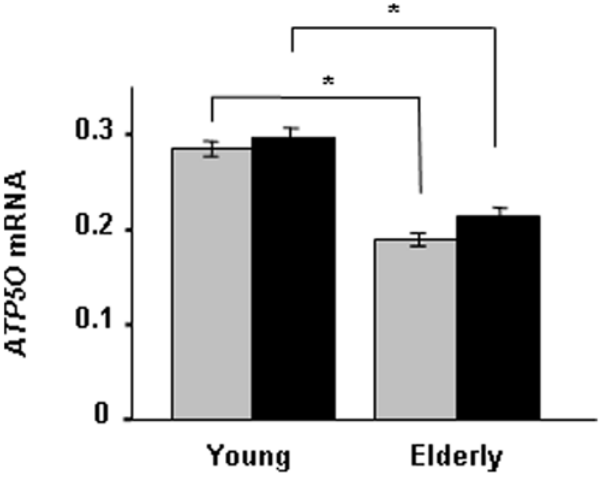
Figure 2. Age associates with ATP5O mRNA expression in skeletal muscle from young ( n =86) and elderly ( n =69) twins. Presented values are ratios between the mRNA expression of ATP5O and the endogenous control cyclophilin A, which was calculated for each sample and expressed as mean 6 SEM. Grey bars, before; and black bars, after a hyperinsulinemic euglycemic clamp. * p ,